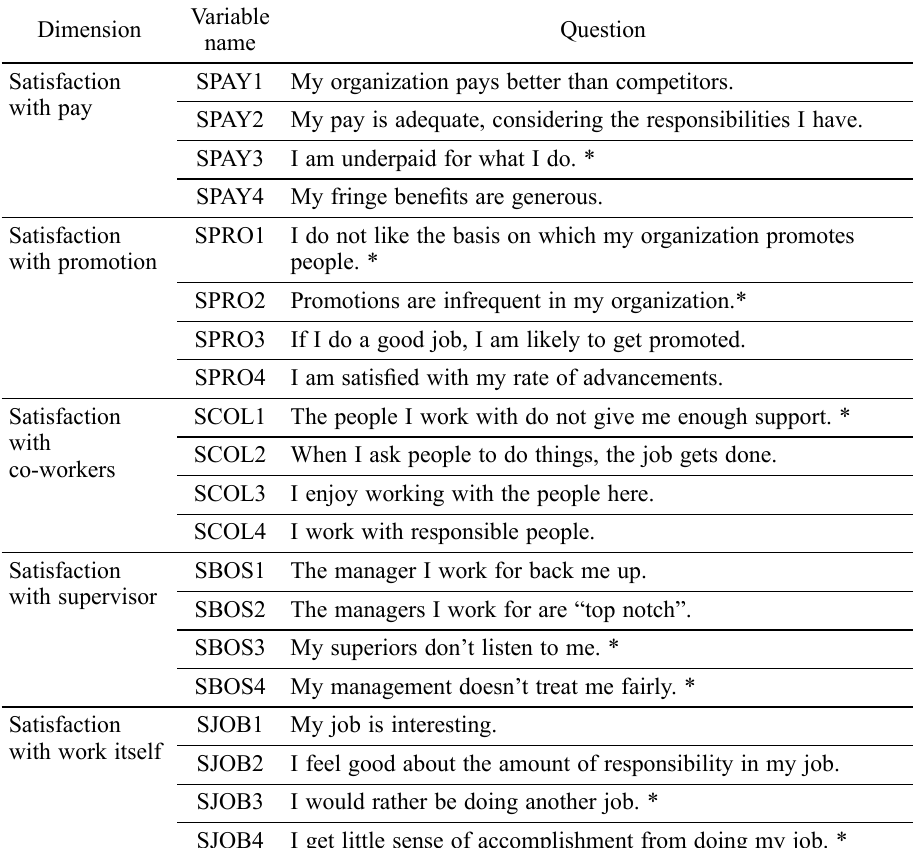
Table 4 . Items for job satisfaction (Adapted from Vitell and Davis (1990)) Variable Dimension name